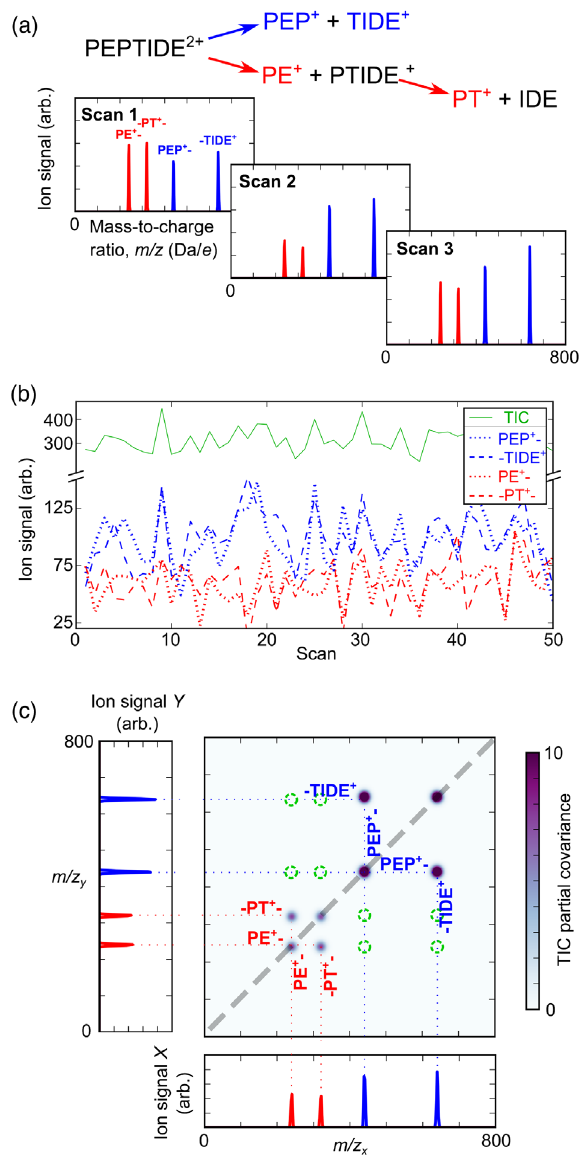
FIG. 1. The principle of 2D-PC-MS. (a) A computer records a series of fragment mass spectra ( “ scans ” ) of a biomolecular ion “ PEPTIDE 2 þ , ” which dissociates along two pathways: blue and red. (b) Because of the statistical nature of the dissociation processes, the signals of each kind of fragment (red and blue) fluctuate randomly from scan to scan. These “ intrinsic ” fluctua- tions are superimposed with “ extrinsic ” ones caused by fluctua- tions in experimental parameters, which affect all the fragments simultaneously and are reflected in the TIC fluctuations (green). Signals formed in the same (blue) or consecutive (red) dissoci- ation processes follow each other and are positively correlated. However, blue fragments are also correlated with red fragments via the TIC fluctuations. (c) Calculating the TIC-based self- correcting partial covariance [Eq. (3)] between each pair of fragment signals produces a map of physical fragment correla- tions: intrinsic correlations between pairs of blue or red fragments are revealed (black islands), while extrinsic correlations are suppressed (green